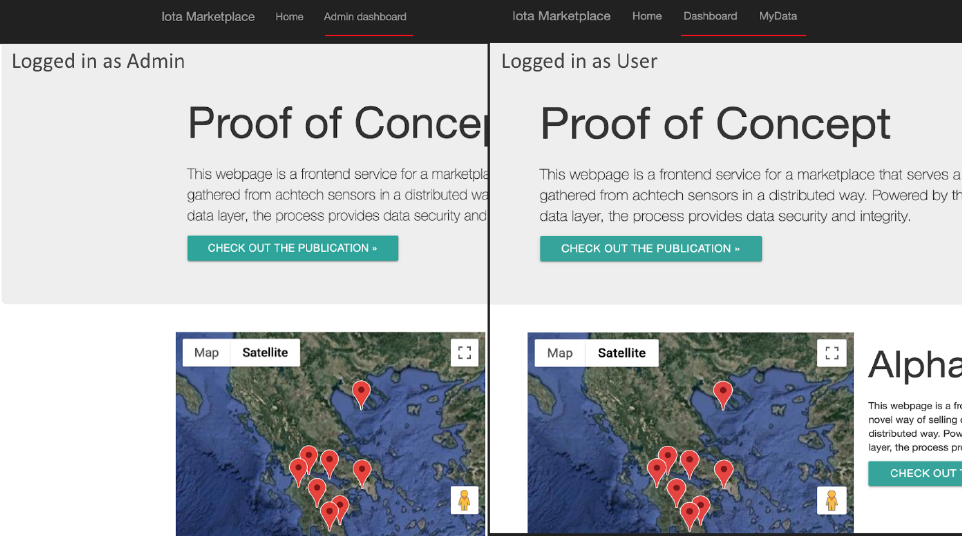
Figure 19. Edge Super Node and Cloud